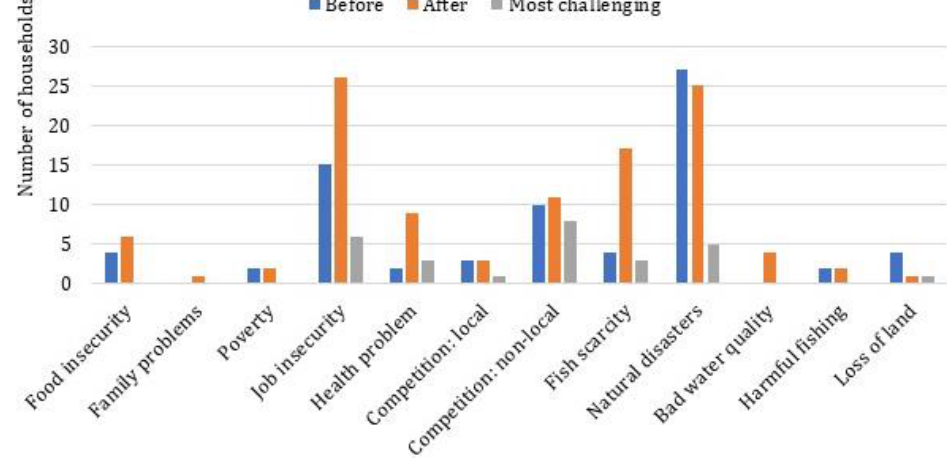
Fig. 2. Livelihood threats: Before and after the FHS incident (own source)